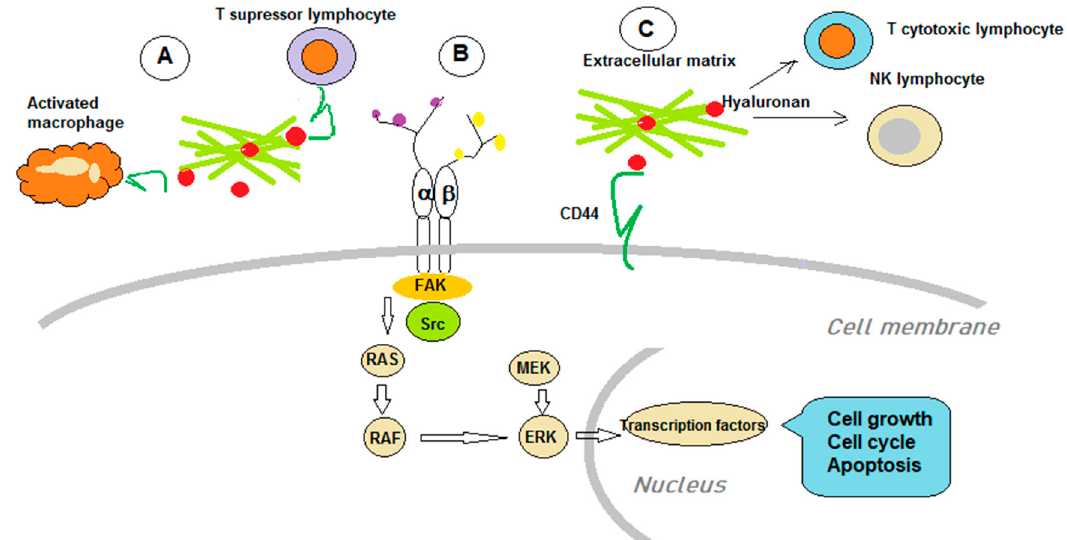
Figure 2. The main mechanisms through which GAGs hinder immune anti-tumoral action. A. HA binds t oCD44-expressing T suppresor cells and to the pool of tumor-associated macrophages contributing to the immuno-suppressive milieu in TME; B. Specific enzymes (e.g., β 1,4-N-acetylgalactosaminyltransferase 3 and β 1,4-galactosyltransferase 3) induce modification of β 1 integrin expressed by tumor cells, triggering intracellular signaling that favor pro-tumorigenic effects in cell growth, cell cycle, and apoptosis. C. HA in the TME binds toCD44 expressed by tumor cells to physically block NK and T cytotoxic lymphocytes’ access to tumor cells.